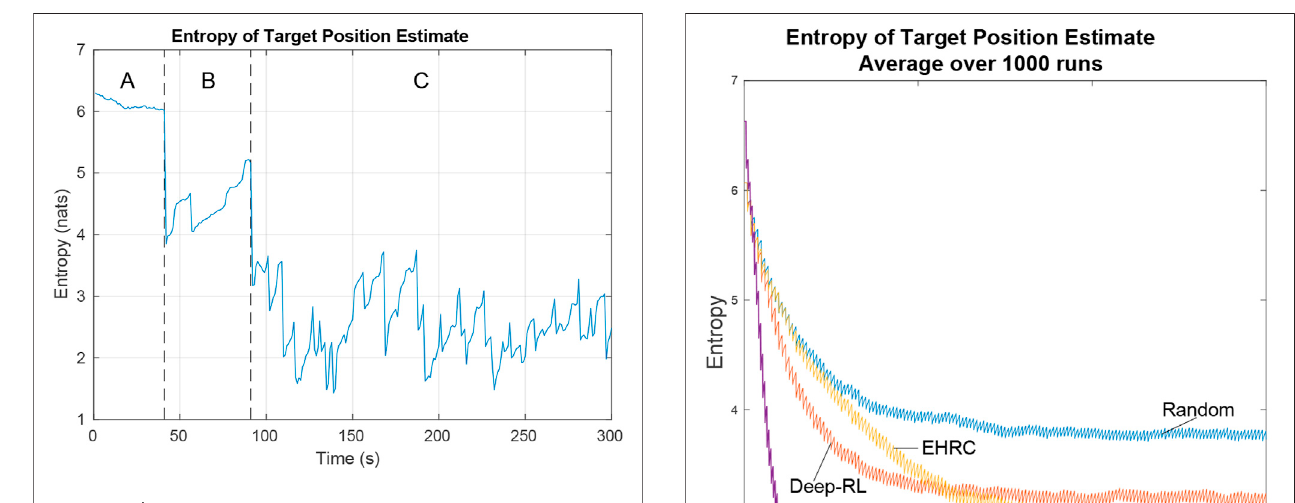
FIGURE 10 | Entropy while simulating the tracking of two targets on a 3 × 3 city block map. In region A , the UAV is searching for targets. In region B , the UAV has located the fi rst target and is looking for the second. In region C , the UAV is trying to minimize entropy across both targets.